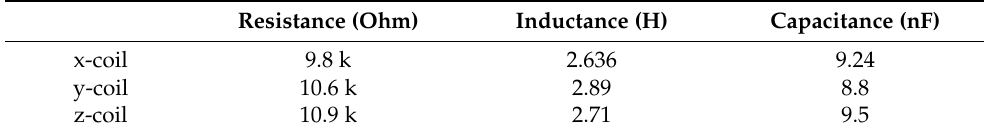
Table 2. Parameters of the three coils in the triaxial-coil